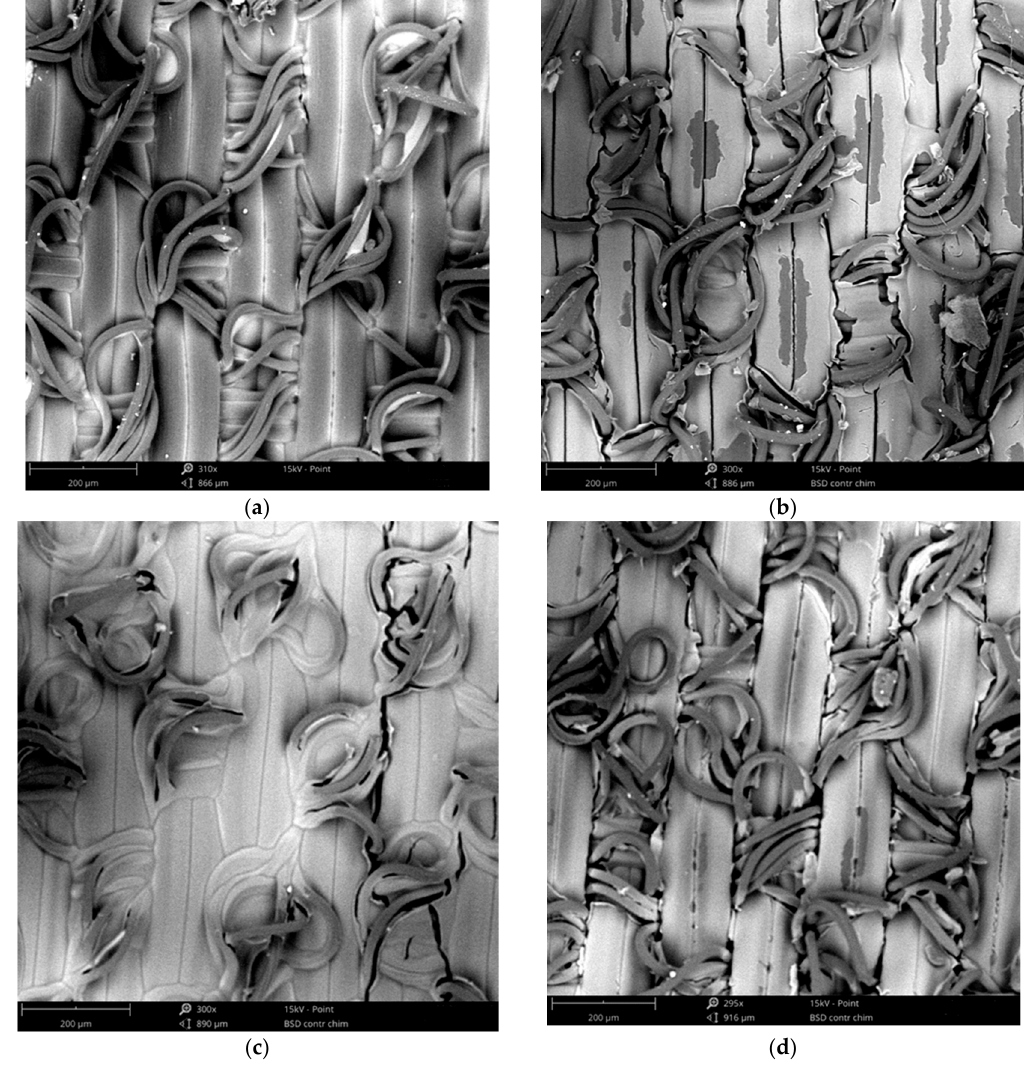
Figure 12. SEM images of polyamide electrodes coated by S1 and S2 solutions ( a ) S1 before washing; ( b ) S1 after 50 washes; ( c ) S2 before washing; ( d ) S2 after 50 washes.